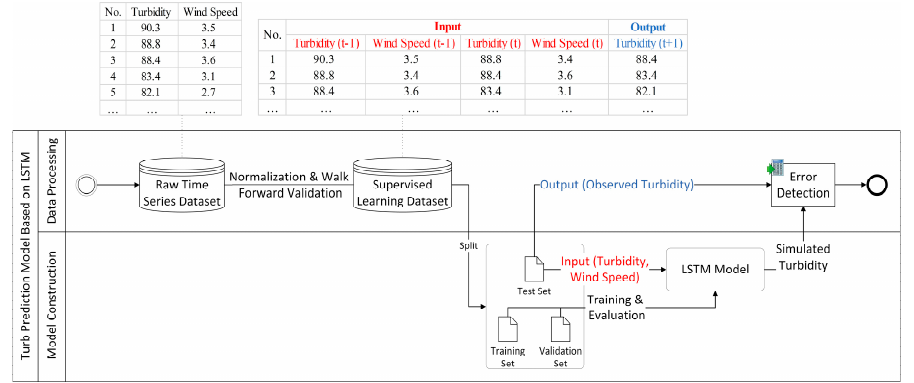
Figure 2. Flow chart of LSTM-based turbidity model development.